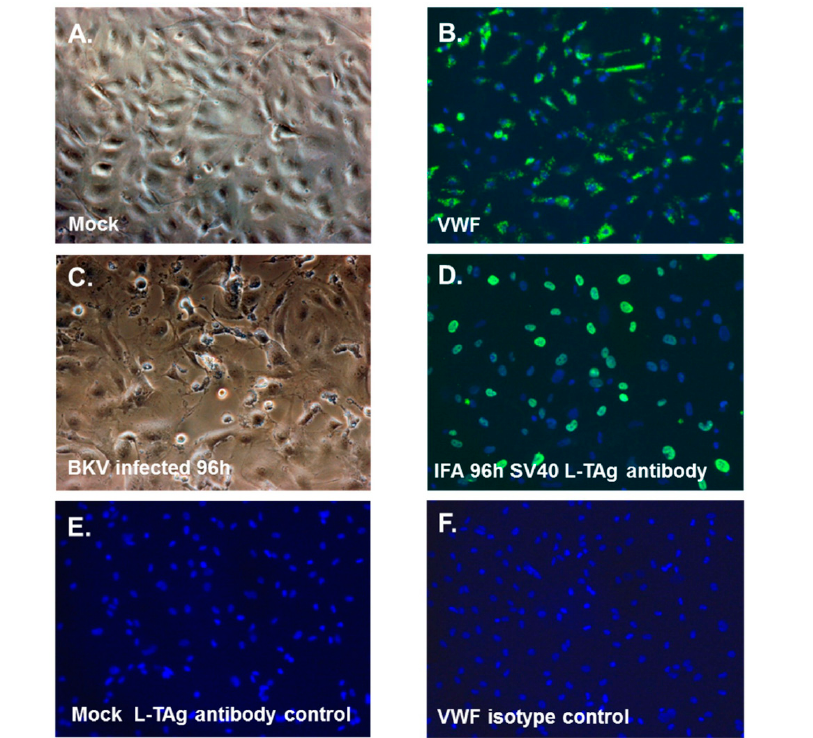
Figure 5. Immunofluorescence analysis of BKV replication in human glomerular endothelial cells. ( A ) Phase-contrast images of mock-infected glomerular endothelial cells, ( B ) immunofluorescence staining of mock-infected glomerular endothelial cells stained with the Von Willebrand factor (VWF) antibody, ( C ) BKV-infected glomerular endothelial cells 96 h after infection, ( D ) immunofluorescence staining of BKV-infected glomerular endothelial cells with the SV40 Large T-Antigen mouse monoclonal antibody 96 h post-infection, ( E ) mock-infected glomerular endothelial cells stained with the SV40 Large T-Antigen antibody, ( F ) mock-infected glomerular endothelial cells stained with the VWF isotype control antibody. Nuclei were stained blue with DAPI. All images ×200 magnification. 3.7. BKV Infected Glomerular Endothelial Cells Express High Levels of VP1 Transcripts and VP1 Protein